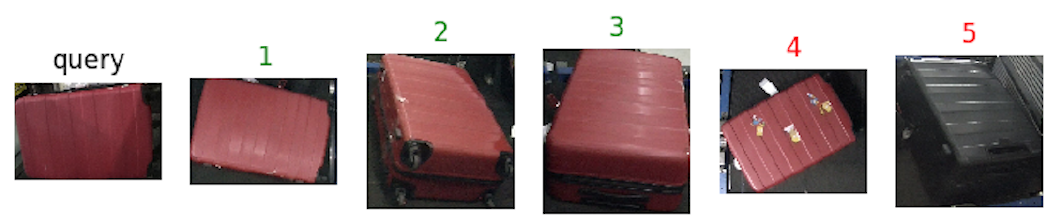
Figure 8. Results with Resnet50 as backbone. Green labels are correct query answers, while red ones indicate different identities.